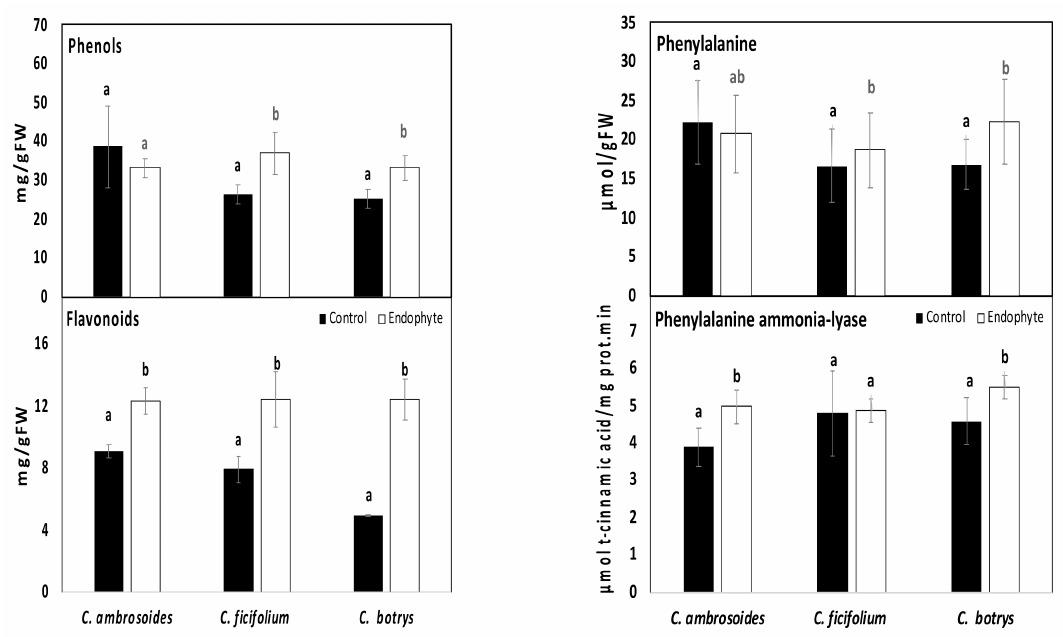
Figure 3. Phenolic, flavonoids, and phenolic biosynthesis enzymes of control and endophytic bacterial-treated Chenopodium ambrosoides, Chenopodium ficifolium, and Chenopodium botrys sprouts. Data are represented by the means of at least 3 replicates, and error bars represent standard deviations. Different small letters above bars indicate significant differences between means at p <